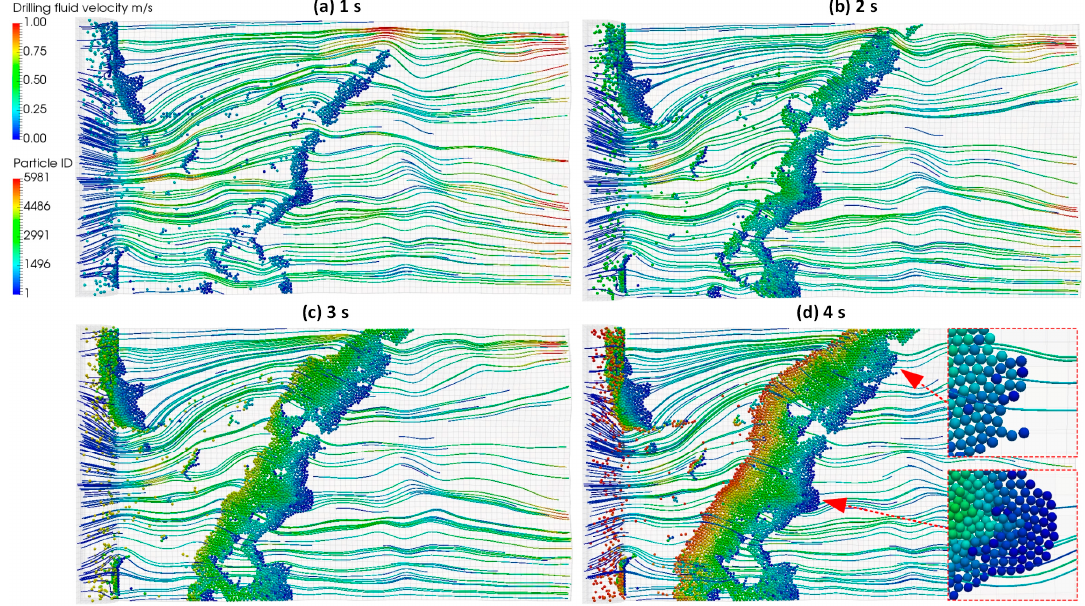
Figure 8. The LCM particle transport and plugging process.